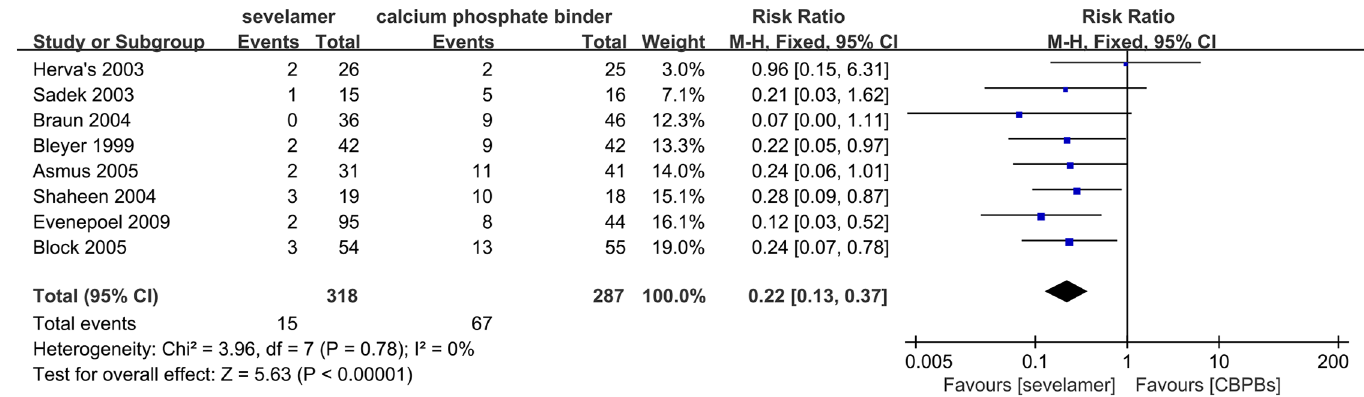
Fig 4. Forest plot of the values of hepercalcemia (above 11.0 mg-dL).